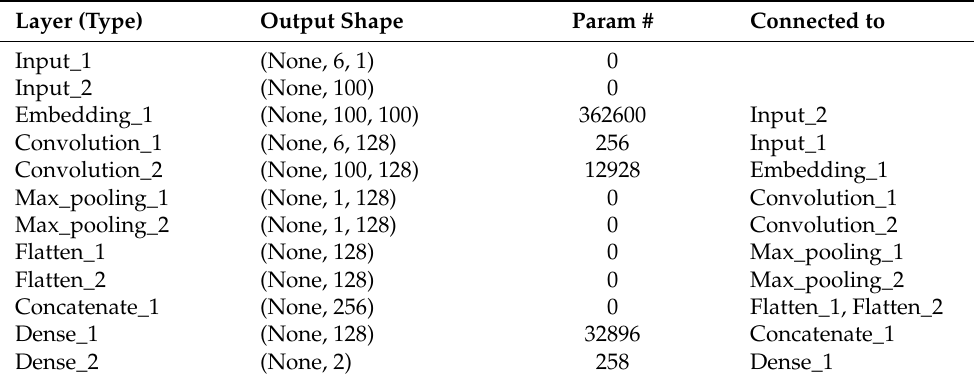
Table 4. The implementation parameters of the MASP